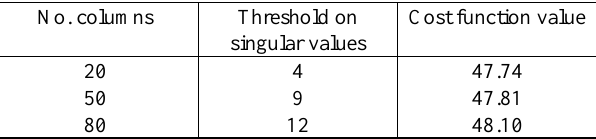
Table 1. Different number of columns in the Hankel matrix with their related cost function values